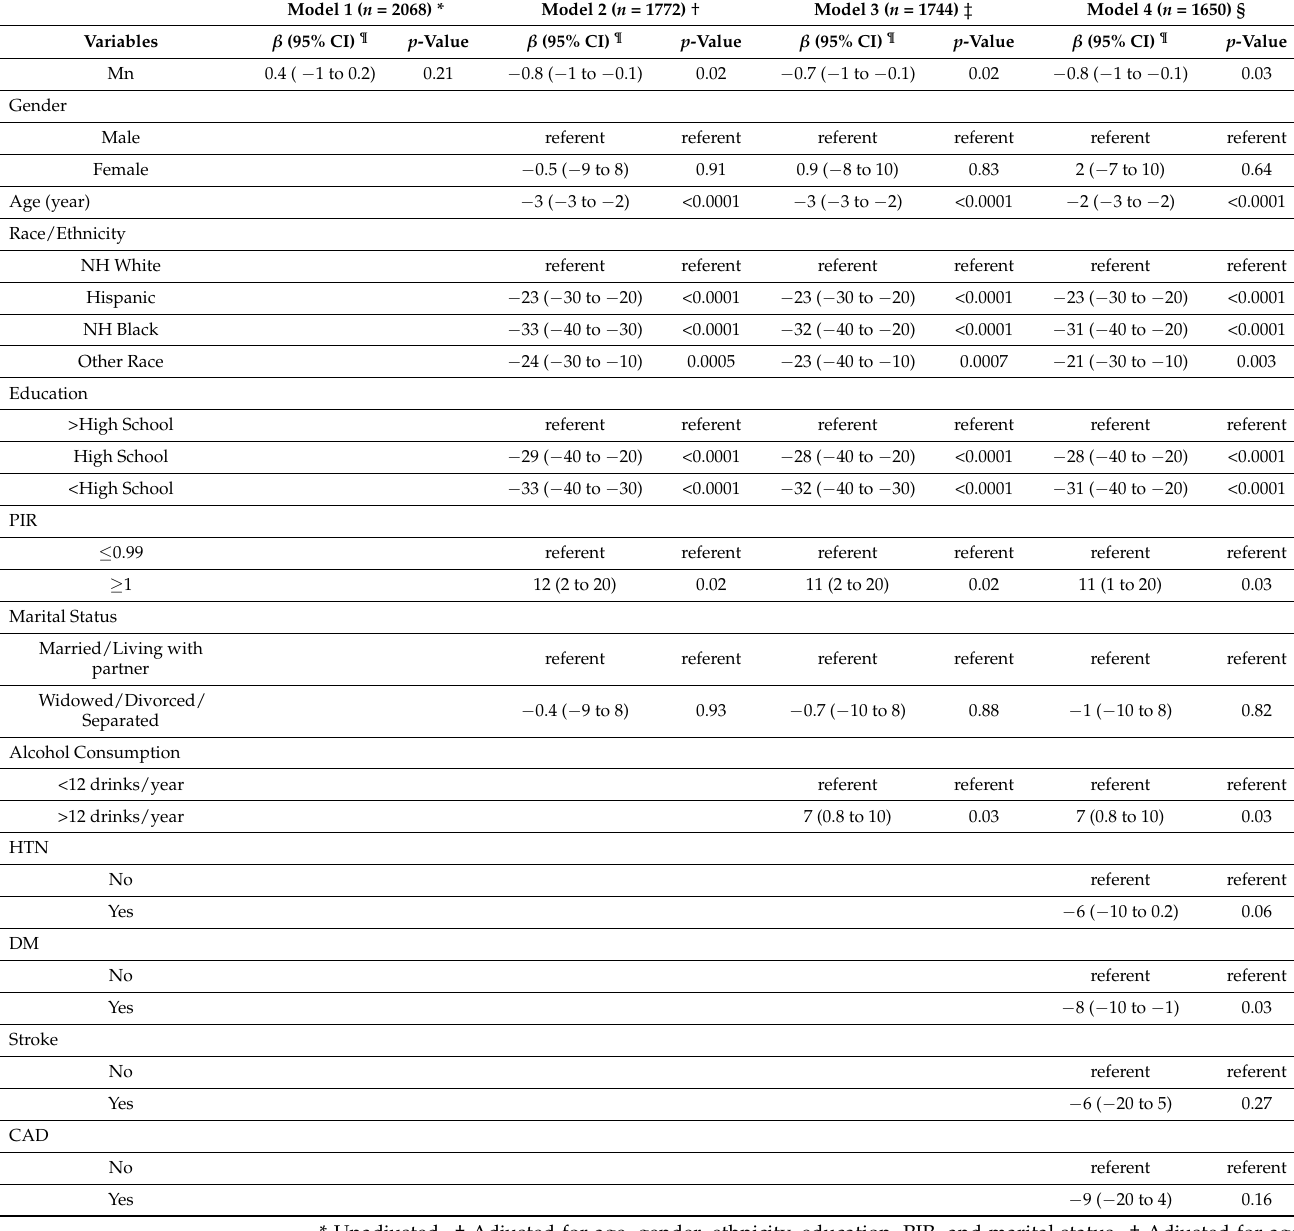
Table 3. Mn-Blood levels (continuous) in relation to